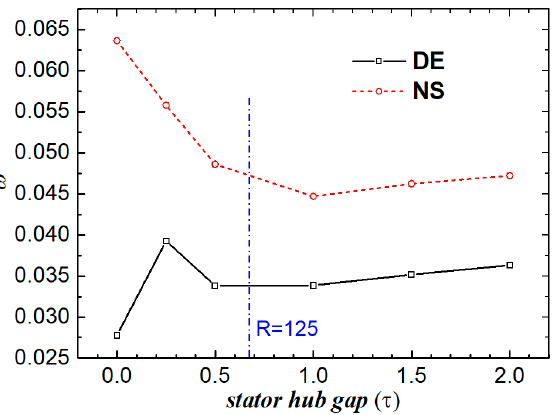
Figure 15. Variation in the cross section-averaged total pressure loss along with the stator hub gap.